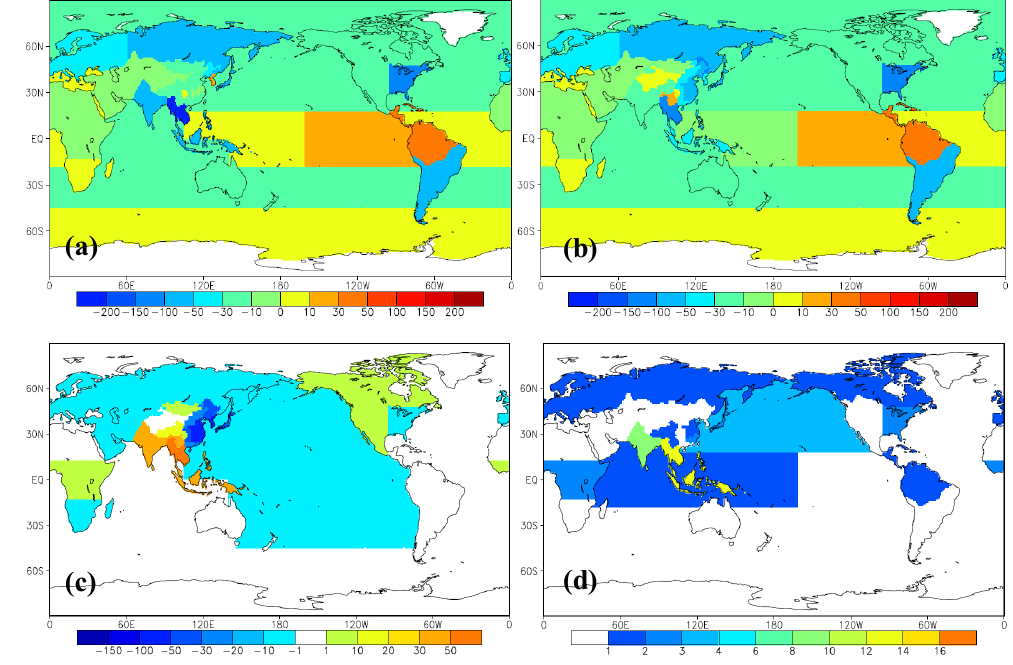
Figure 6. Inverted global carbon flux for (a) Case GV, unit: gCm − 2 yr − 1 ; (b) Case GVCT, unit: gCm − 2 yr − 1 ; and impact of CONTRAIL CO 2 on (c) the inverted carbon fluxes, Case GVCT–Case GV, unit: gCm − 2 yr − 1 and (d) posterior uncertainties, (Case GV–Case GVCT) × 100/Case GV, unit: %; averaged for 2006 to 2008.